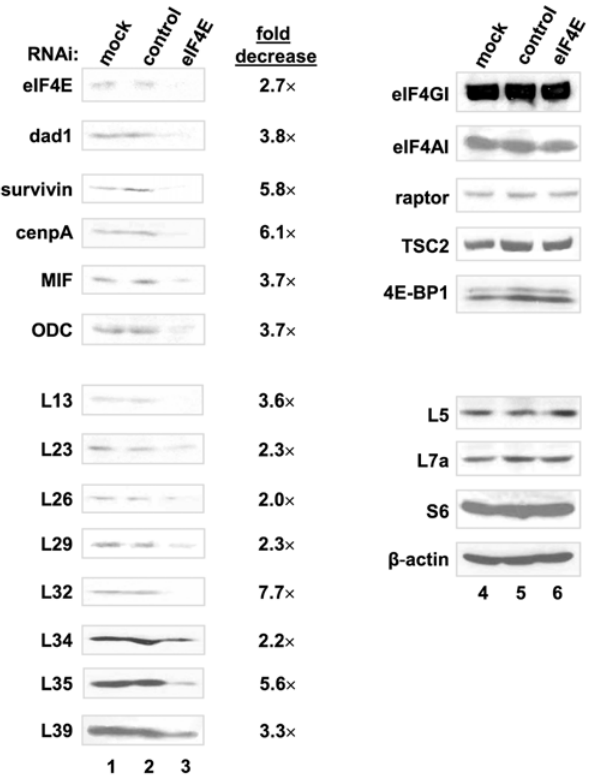
Figure 4. siRNA mediated knockdown of eIF4E in NIH 3T3 cells. NIH 3T3 cells were transiently transfected with an siRNA against murine eIF4E or with a control siRNA, 4E-T-inv (scrambled sequence of human 4E-T), for 48 hr. Cells were lysed, and protein extracts were subjected to SDS-PAGE, followed by western blot analysis. The RNAi-mediated knockdown was repeated three times.